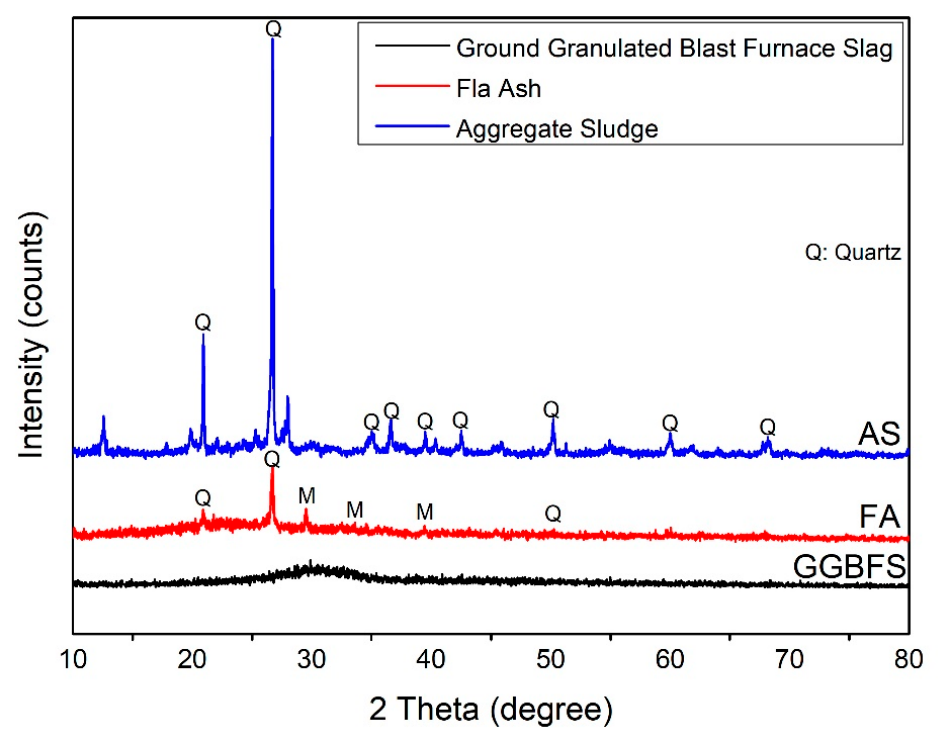
Figure 2. The XRD spectrum of Aggregate Sludge, Fly Ash, and Ground Granulated Blast Furnace Slag.